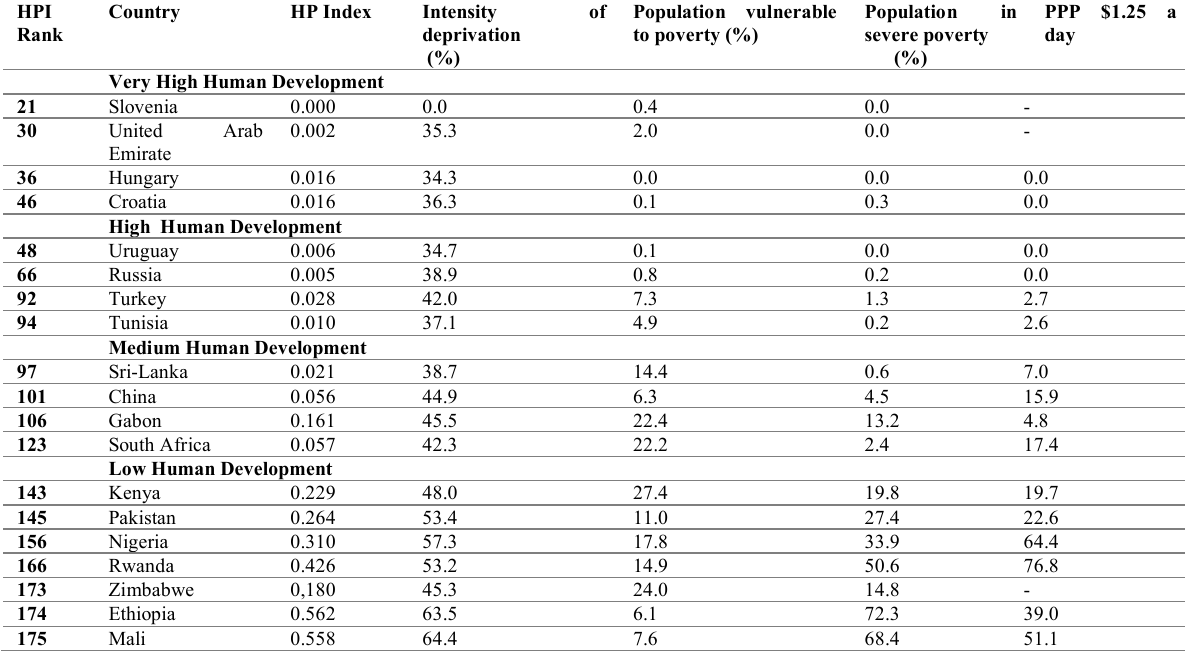
Table 3: Human Poverty Index and its